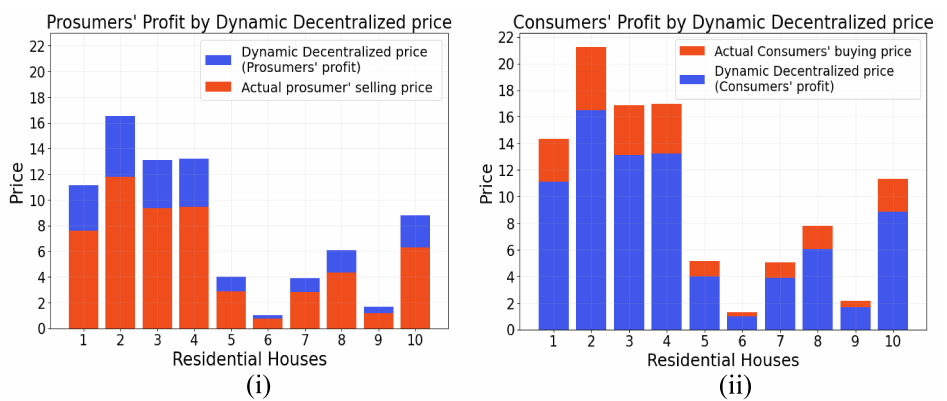
Figure 4. Prosumer/Consumer’s profit using the proposed DT-P2PET scheme. ( i ) Prosumer’s profit. ( ii ) Consumer’s profit. Table 3. Profit generation for prosumer and